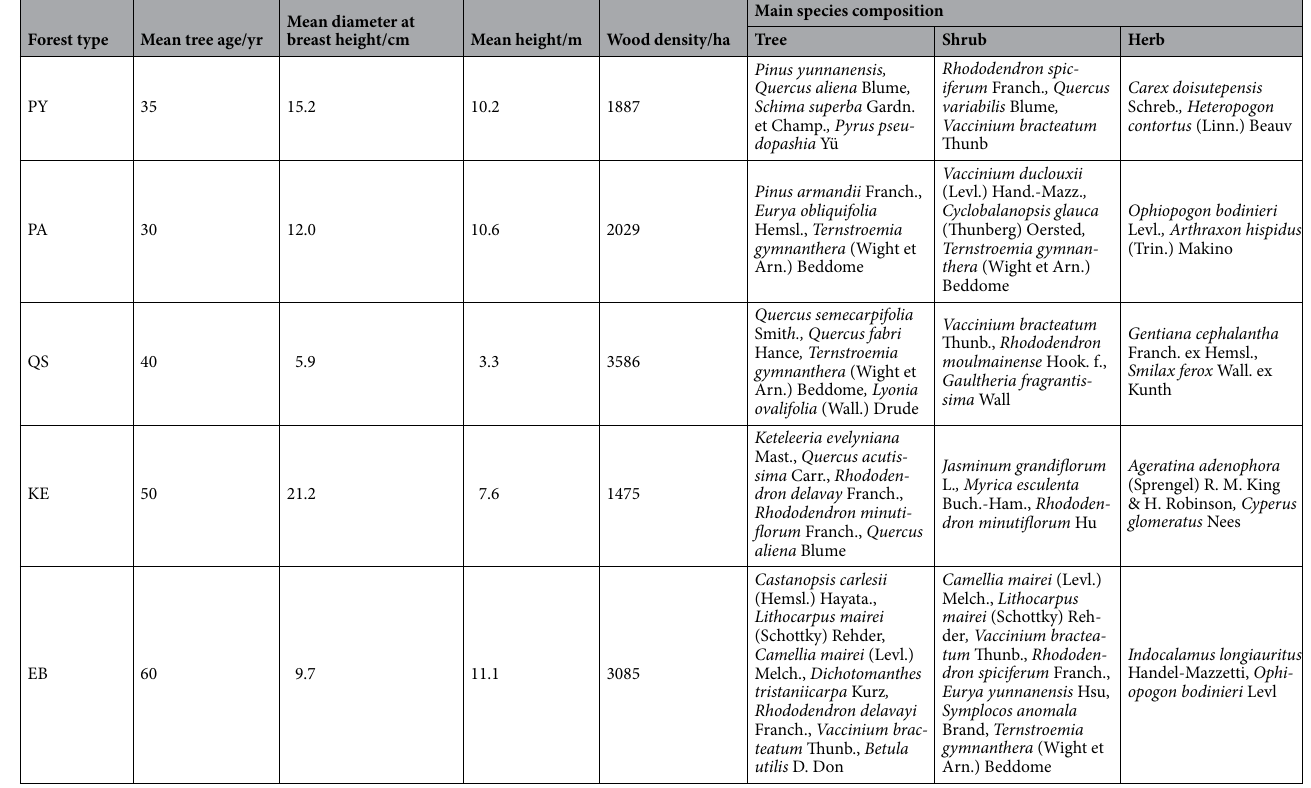
Table 1. Stand information of various study forests in Mopan Mountain in the central Yunnan